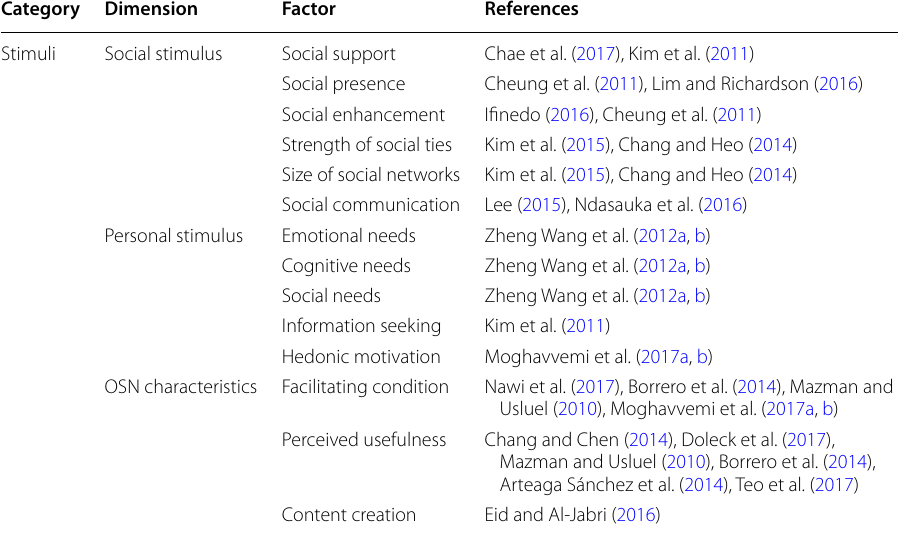
Table 4 Factors classified under stimulus Category